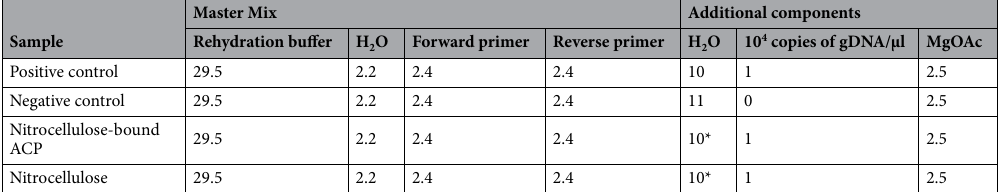
Table 1. Volumes for each component present in RPA reactions for experiments in Fig. 2B. Volumes for each component present in RPA reactions in microliters. * Water in which nitrocellulose containing ACP or plain was agitated.